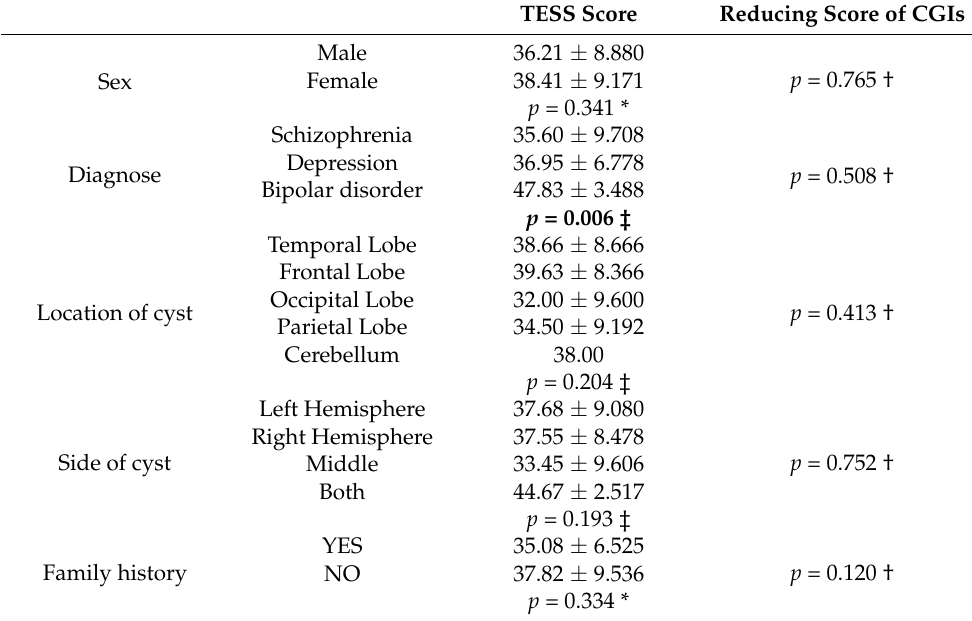
Table 3. Other factors that may affect efficacy and side